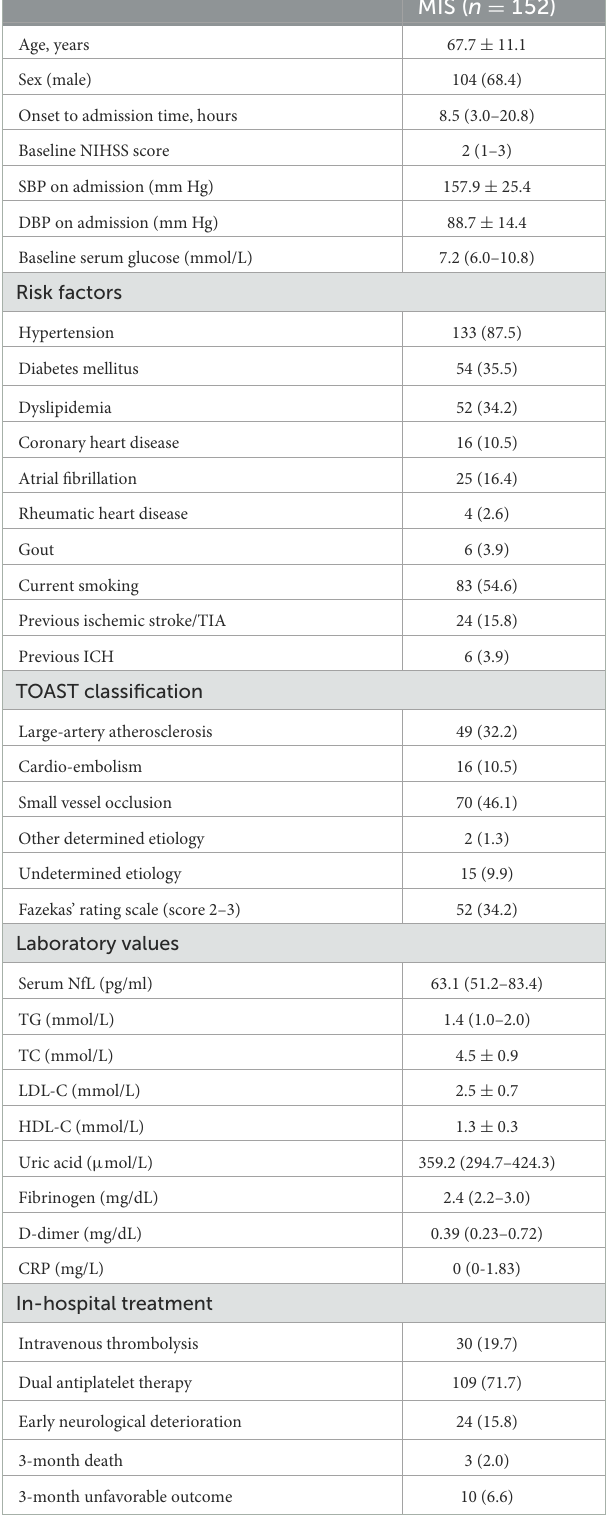
TABLE 1 Baseline characteristics and clinical outcomes of patients with MIS.